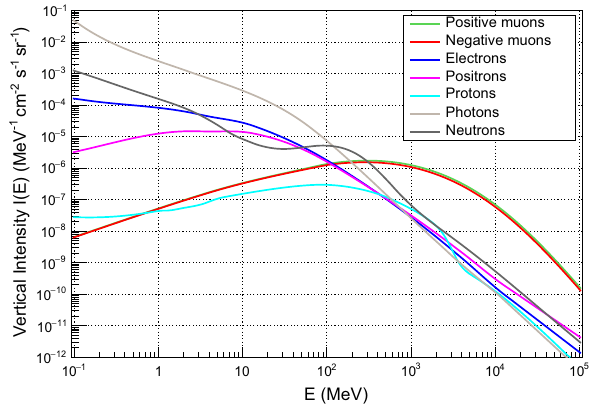
Fig. 6 Differential vertical intensity of secondary cosmic rays at sea level as a function of the energy at (45 ◦ N 15 ◦ E) Earth Position and on August 1, 2018, computed using the PARMA model as described in the text. The contributions from the various particle species are plotted